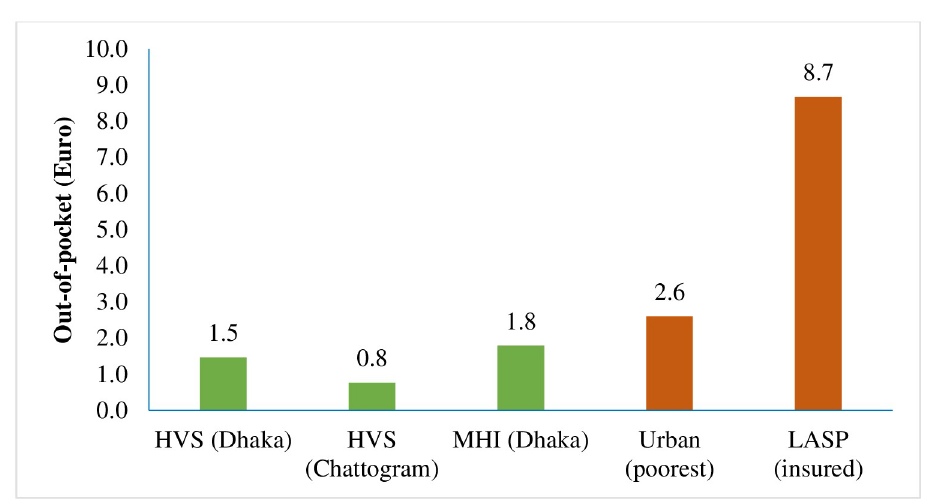
Fig 5. Out-of-pocket spending of the extreme poor for healthcare (per person per month) in Euro.